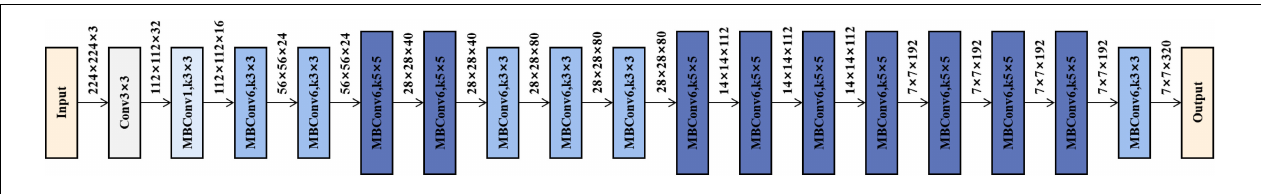
FIGURE 2 | EfficientNet-B0